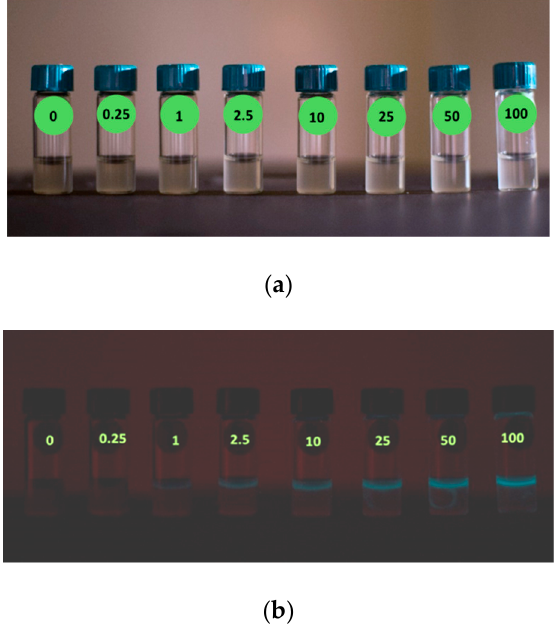
Figure 3 . Bioluminescence of the E. coli reporter to 0 (tap water), 0.25; 1; 2.5; 10; 25; 50 or 100 µg/L Hg 2+ treatment in water: ( a ) light conditions; ( b ) dark conditions (20 s exposure time).